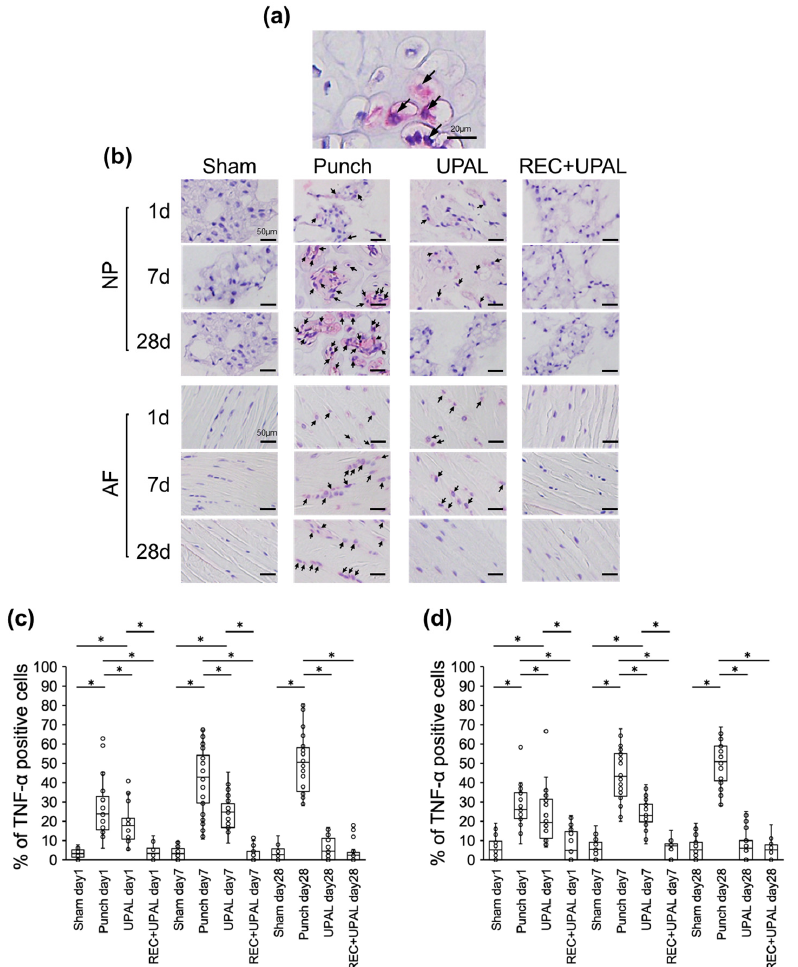
Figure 2. A mixed solution of REC and UPAL inhibits tumor necrosis factor alpha (TNF- α ) production. Immunohistochemical analysis was performed on postoperative days 1, 7, and 28 to detect TNF- α levels ( a – d ). ( a ) Representative image of TNF- α -positive nucleus pulposus (NP) cells (allows). TNF- α - positive cells are stained in red, and nuclei are stained in purple. Scale bar, 20 µ m. ( b ) Representative IHC staining of TNF- α of NP and annulus fibrosus (AF) tissues on postoperative days 1, 7, and 28. Arrows indicate TNF- α -positive cells. Scale bar, 50 µ m. Percentage of TNF- α -positive cells of NP tissue ( c ) and AF tissue ( d ). An asterisk (*) indicates a p -value less than 0.01. The boxes represent the median and interquartile range, while the vertical lines show the range at each time point (n = 3 rats; n = 6 IVDs in each